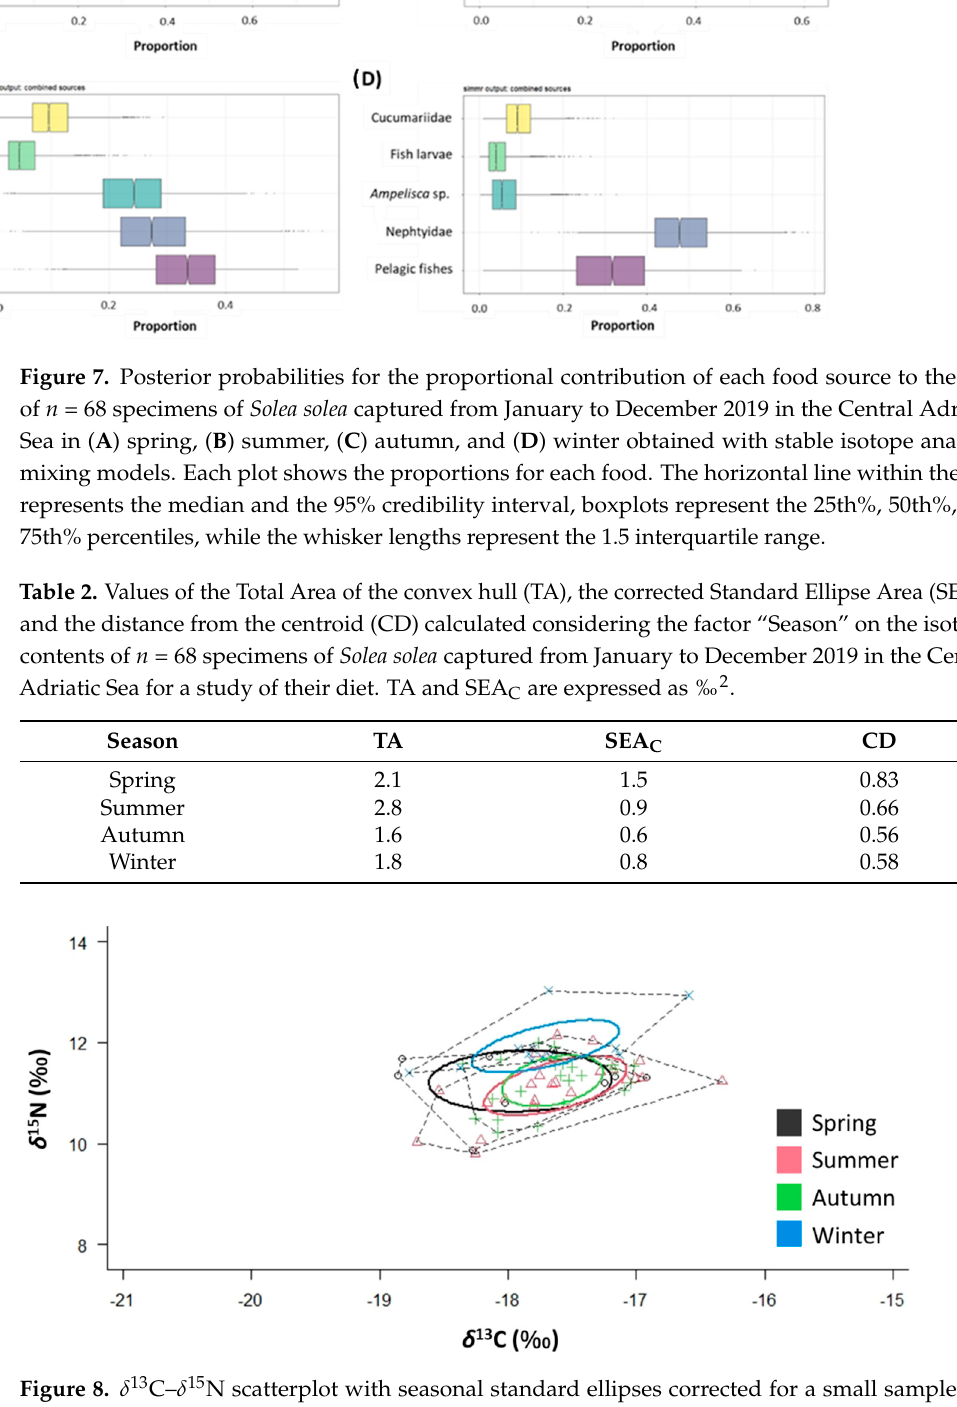
Figure 8. δ 13 C– δ 15 N scatterplot with seasonal standard ellipses corrected for a small sample size population (SEA C ) overlaid for the specimens ( n = 68) of Solea solea captured in the Central Adriatic Sea between January and December 2019 ( p interval =